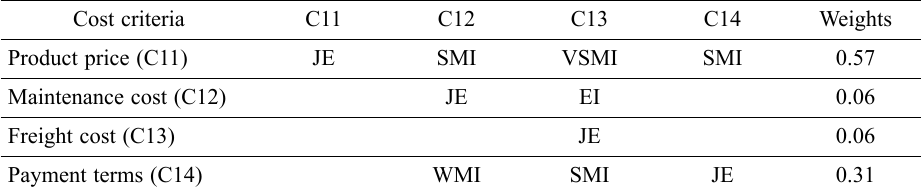
Table 4. Local weights and pairwise comparison matrix of cost (C1) sub-criteria